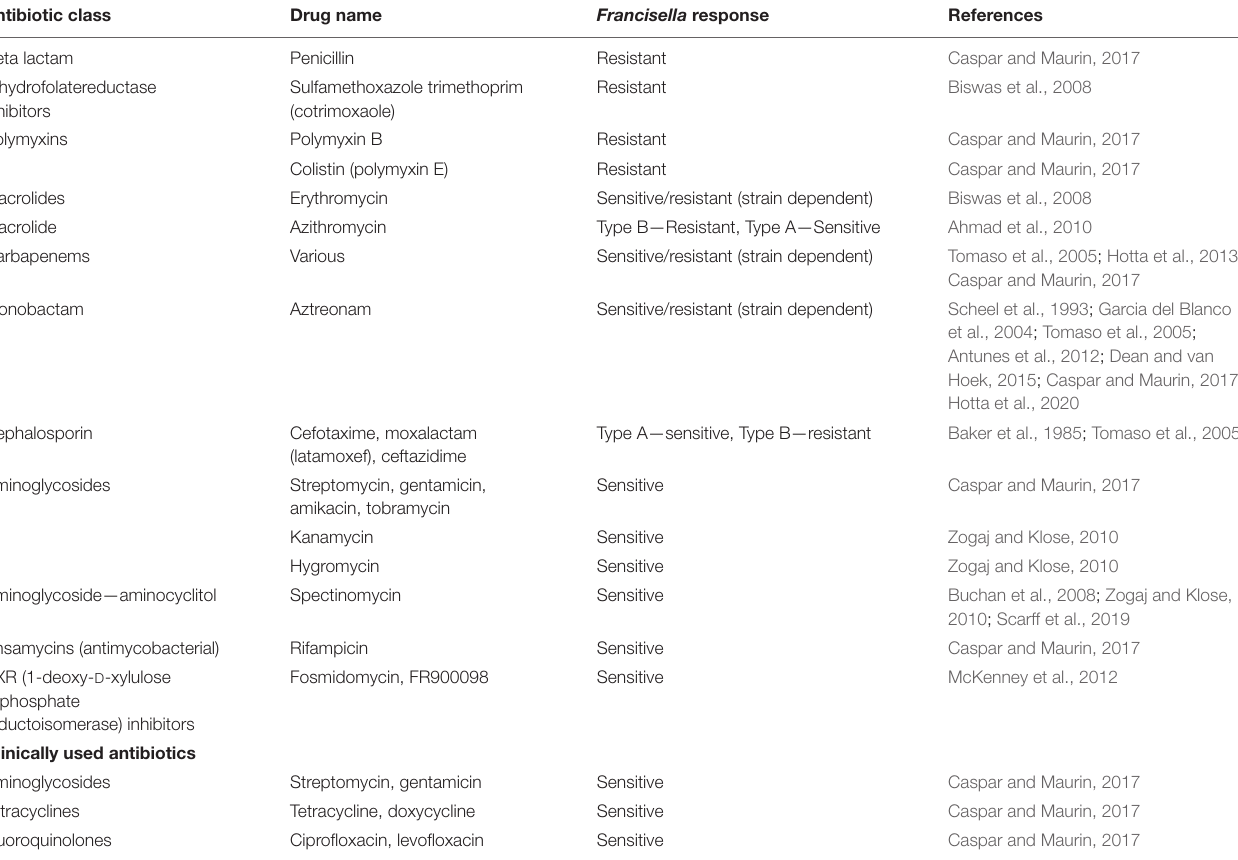
TABLE 1 | Intrinsic antibiotic resistance in Francisella